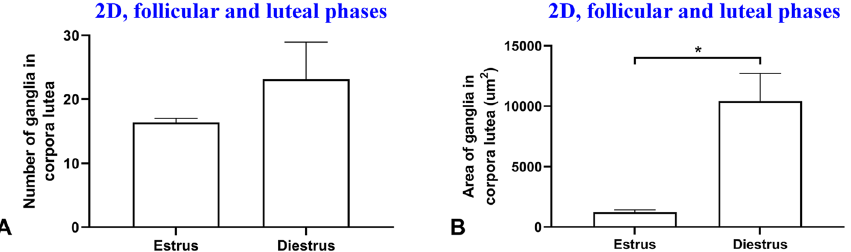
Figure 5. Comparisons of means and standard errors of number of ganglia in the two-dimensional studies to show the relationship of corpora lutea function and increase in ganglia number ( A ) and area ( B ) in the mouse